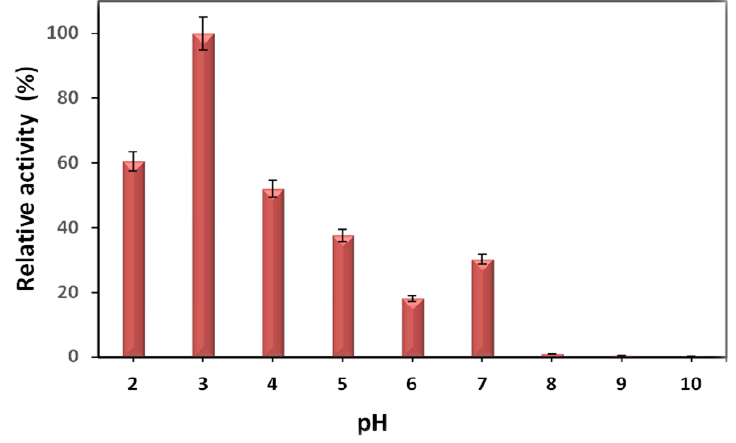
Figure 6. pH effect on the activity the immobilized BCL by physical adsorption (PA) onto graphene